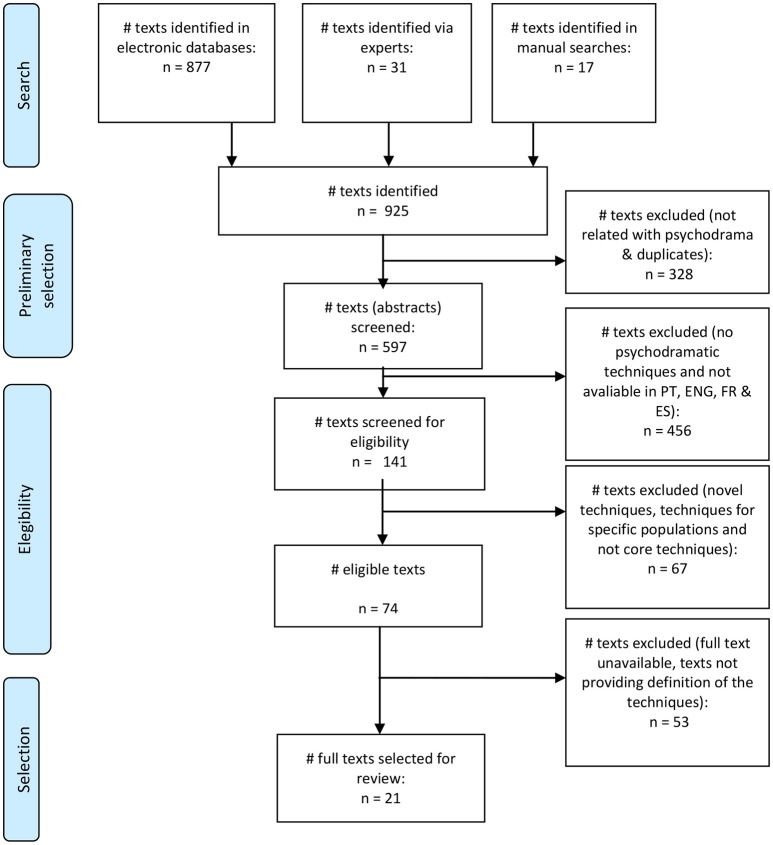
Selected texts. Adapted from Moher et al. (2009).